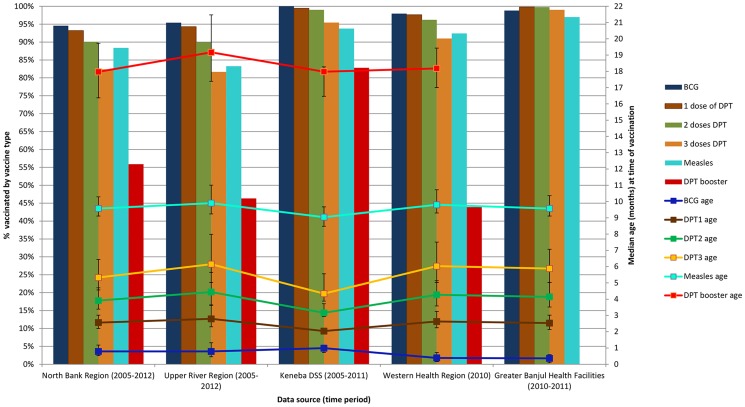
Proportion of eligible children vaccinated and median age (in months) by vaccine type and by region in The Gambia.Blue bars: proportion who received BCG on time. Brown bars: proportion who received DPT1 on time. Green bars: proportion who received DPT2 on time. Orange bars: proportion who received DPT2 on time. Turquoise bars: proportion who received measles vaccine on time. Red bars: proportion who received DPT booster on time. Blue line: Median age (in months) for BCG. Brown line: Median age (in months) for DPT1. Green line: Median age (in months) for DPT2. Orange line: Median age (in months) for DPT3. Turquoise line: Median age (in months) for measles vaccine. Red line: Median age (in months) for DPT booster. Vertical bars: Interquartilte range in months of age at vaccination.